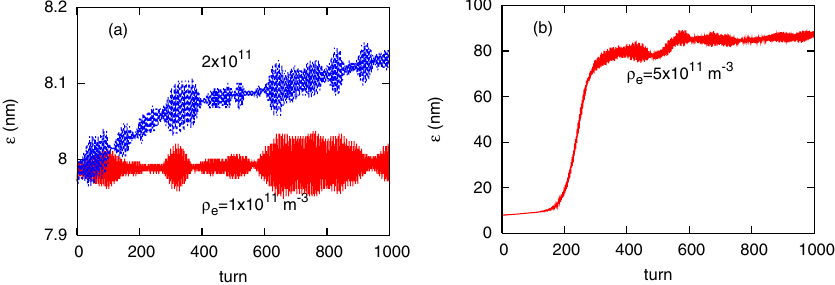
FIG. 21. (Color) Emittance growth for electron distribution along the lattice given in Fig. 19. A strong-strong simulation based on the (cid:5) 1 ; 2 (cid:2) 10 11 and 5 (cid:2) 10 11 m (cid:1) 3 , particle-in-cell method is used. Plots (a) and (b) are (cid:10) e